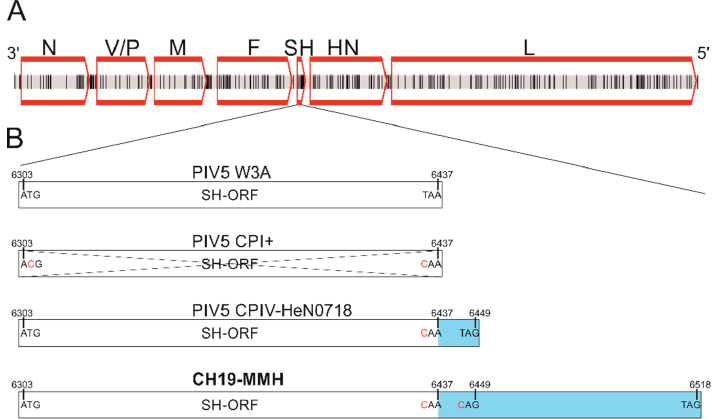
Figure 1. Schematic presentation of the PIV5 CH19-MMH genome and comparison to other PIV5 strains. ( A ) Nucleotide differences to the closest related PIV5 strain H221 are marked as black vertical lines. Open reading frames (ORFs) are indicated by red boxes. N: nucleocapsid protein, V: V-protein,